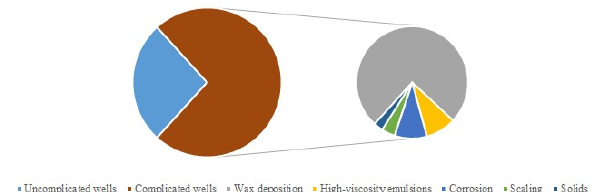
Figure 1. Composition of operational and complicated funds of the Perm Krai.